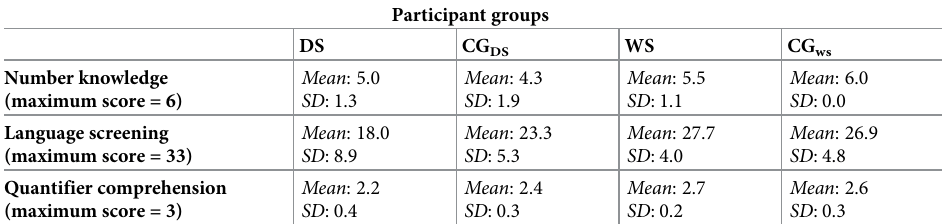
Table 3. Mean scores and standard deviations of the experimental